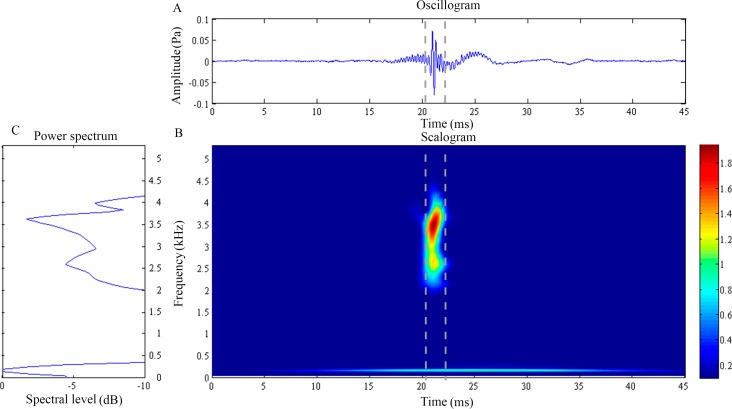
Wavelet analysis results of the feeding click produced by Doryichthys deokhathoides.(A) Oscillogram, (B) scalogram and (C) energy spectral density of the feeding clicks produced by Doryichthys deokhathoides. Vertical lines in (A) and (B) indicate the measured signal duration.